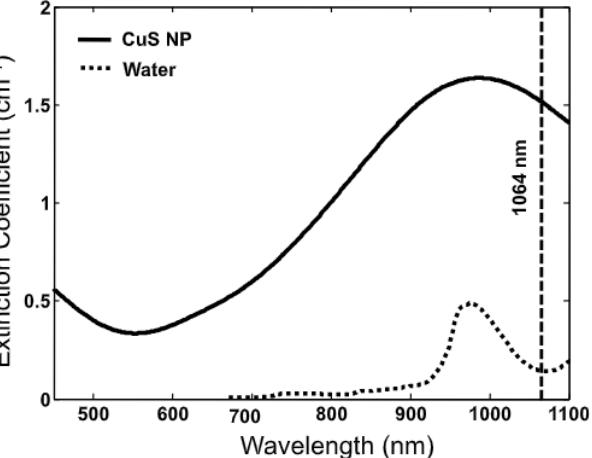
Figure 15. Extinction coefficient spectra of 0.5 mM CuS NP aqueous solution (solid line) and pure water (dotted line). The vertical line is positioned at 1064 nm. Reprinted from Ku et al., ACS Nano 2012, 6, 8: 7489–7496 [35], with permission of the Optical Society of America.